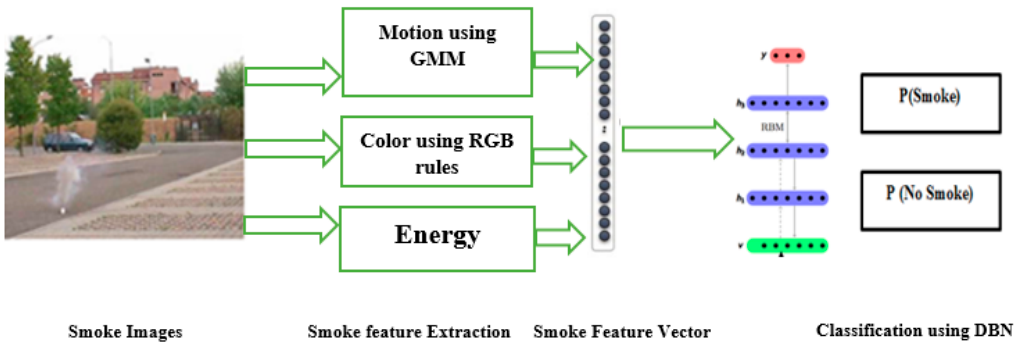
Figure 5. Smoke detection and classification using the proposed method based on the deep belief network.